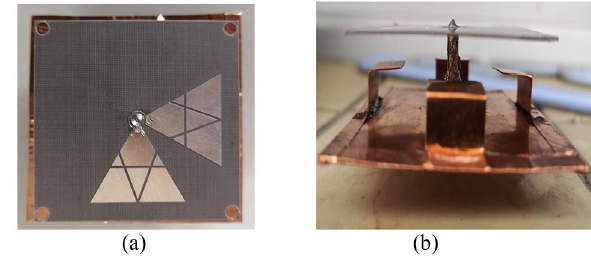
Figure 8. Prototype of the proposed antenna. ( a ) Top view, ( b ) side